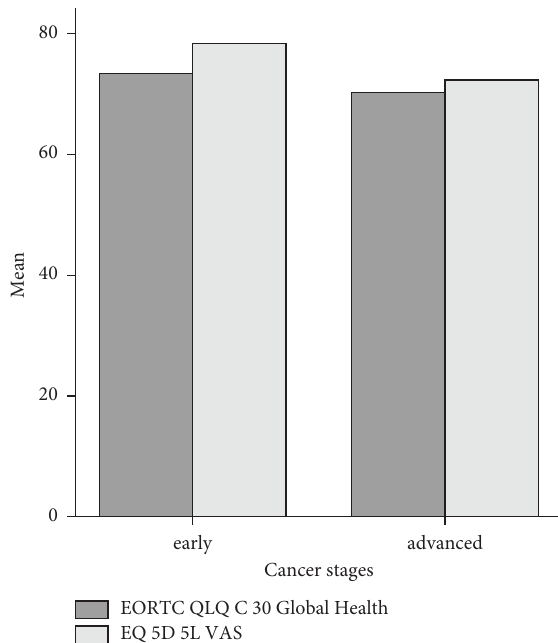
Figure 5: Scores of global health and VAS based on the cancer stages.